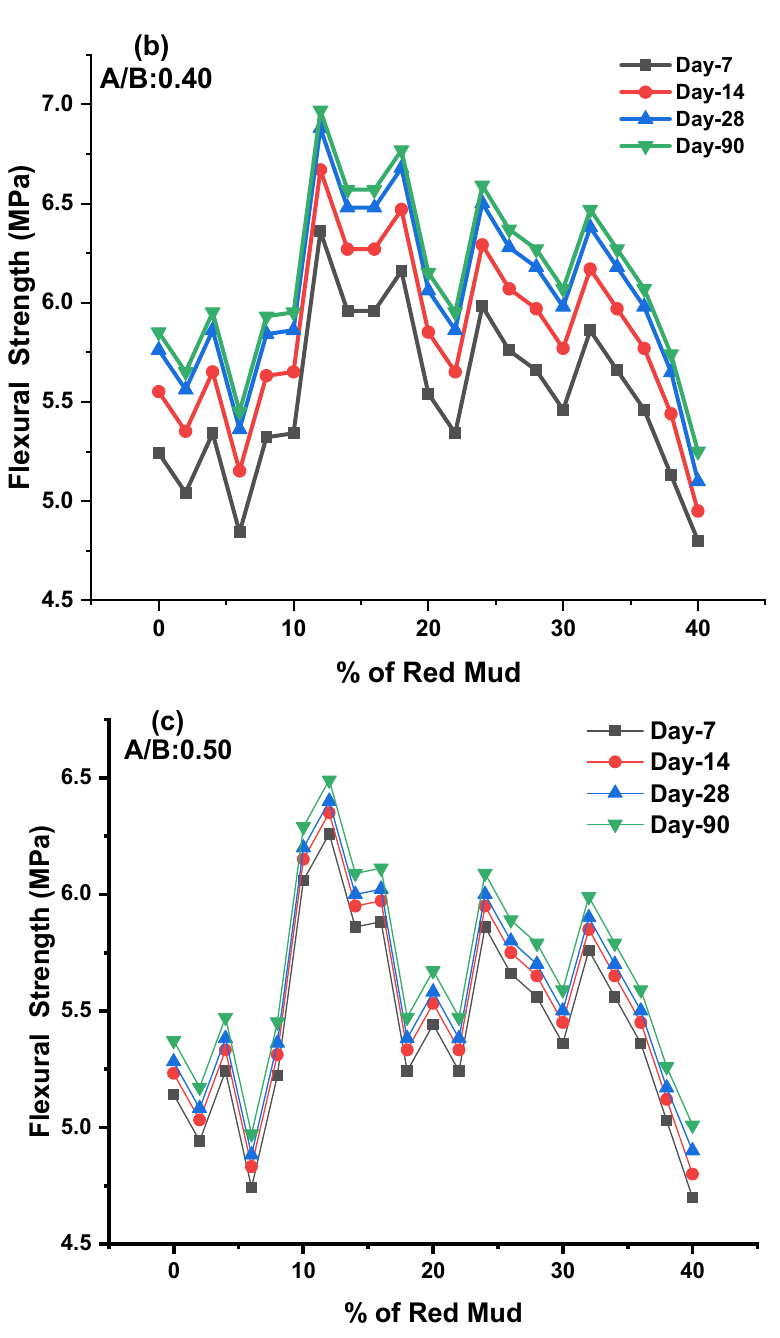
Figure 8. ( a – c ) These represent the FS results for 7, 14, 28, and 90 days for A/B ratio of 0.3, 0.4, and 0.5 for various mixes of GPC, respectively.